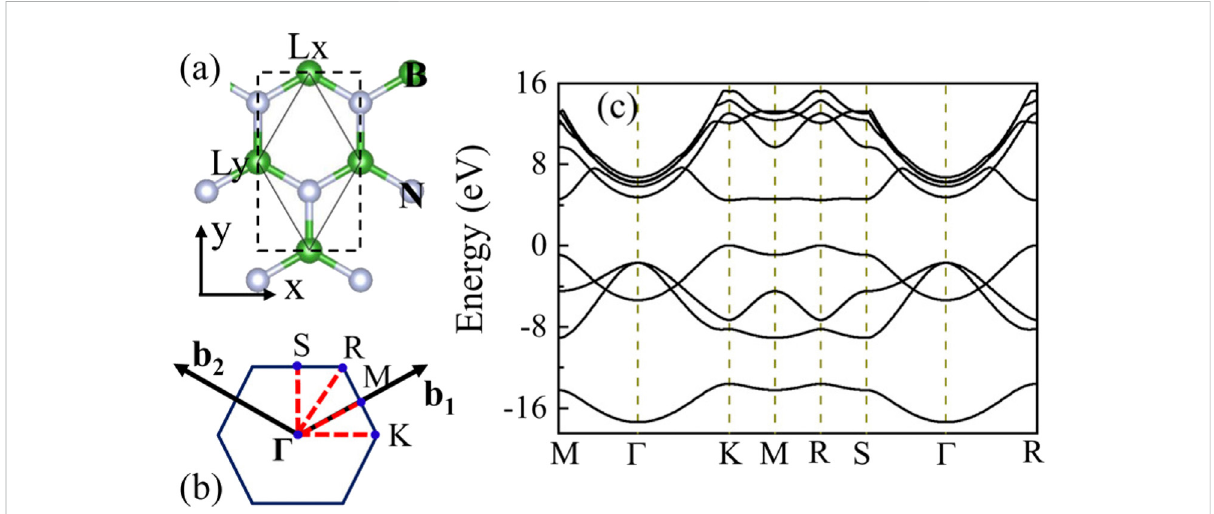
FIGURE 1 (A) Schematic diagramofthestrain-free monolayer hBN.The primitive (hexagonal) cell andcubic unitcell areframed bysolidand dashedlines. (B) The fi rstBrillouinzoneofthestrain-freemonolayerhBNandthecorrespondinghighsymmetricpoints Γ ,K,M,R,andSinthereciprocalspace. (C) The band structure of the strain-free monolayer